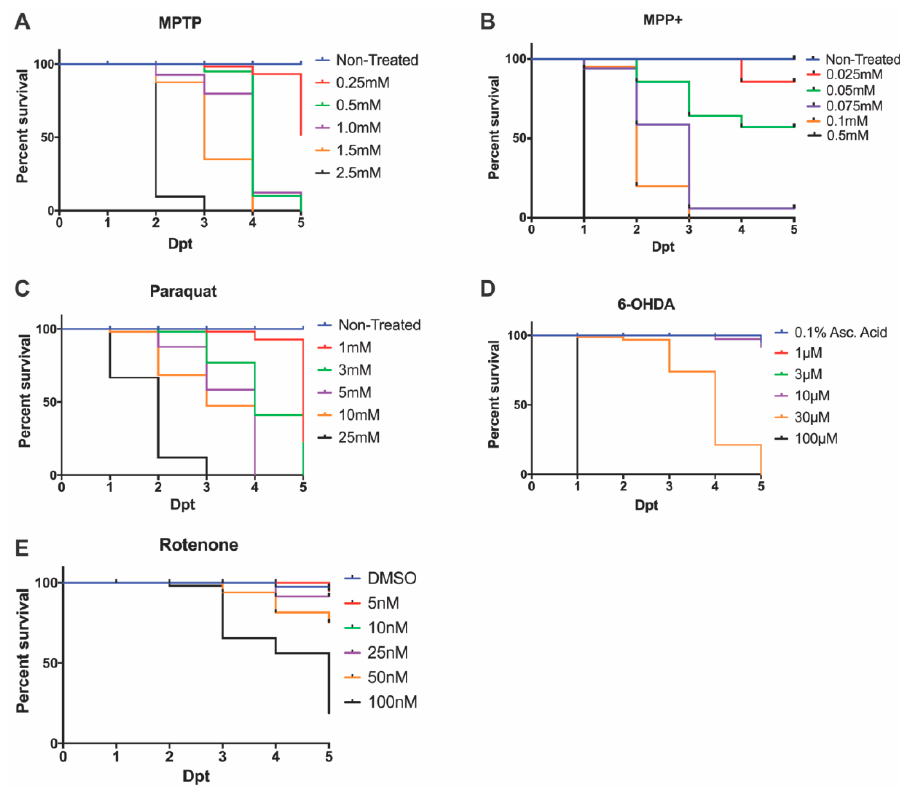
Figure 1. Zebrafish larvae survival following neurotoxin exposure. 3 dpf embryos were exposed to varying concentrations of ( A ) MPTP, ( B ) MPP + , ( C ) paraquat, ( D ) 6-OHDA, and ( E ) rotenone to determine the LC 50 or sub-lethal dose. Lethality was quantified every 24 hpt until the zebrafish reached 7 dpf.